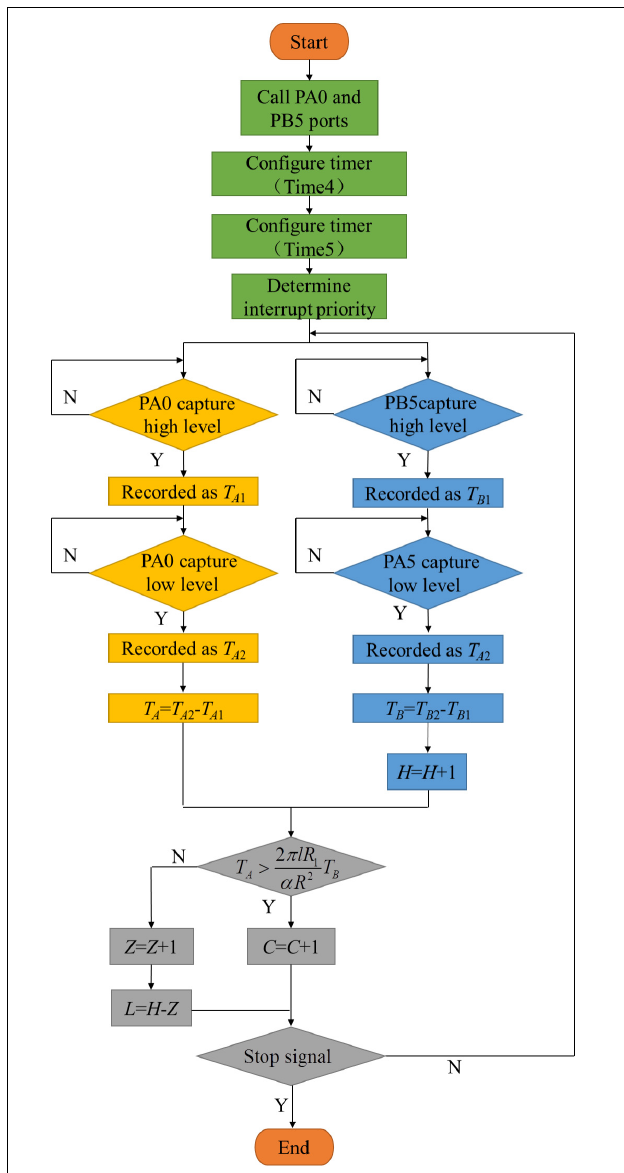
FIGURE 6 | Program flow chart. L is the miss-seeding amount; C is the reseeding amount; H is the theoretical seeding amount; and Z is the total amount of